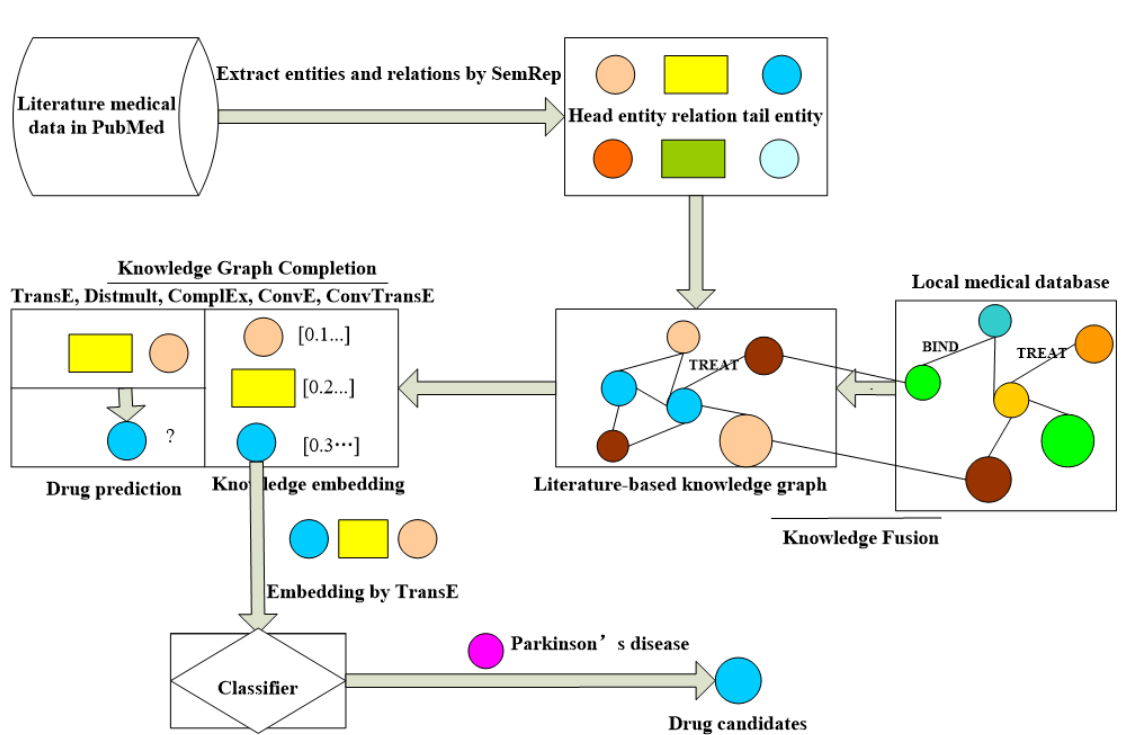
Figure 2. The framework of our drug repurposing